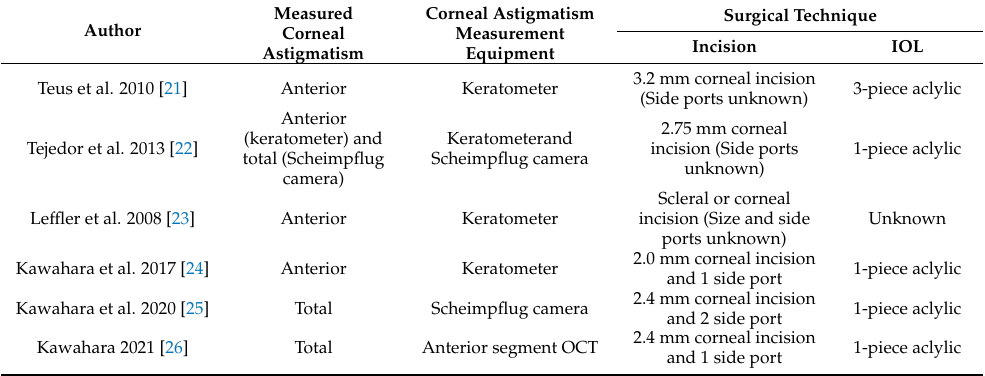
Table 2. Corneal astigmatism measurement and surgical technique employed in each study in Table 1. Measured Corneal Astigmatism Author Corneal Astigmatism